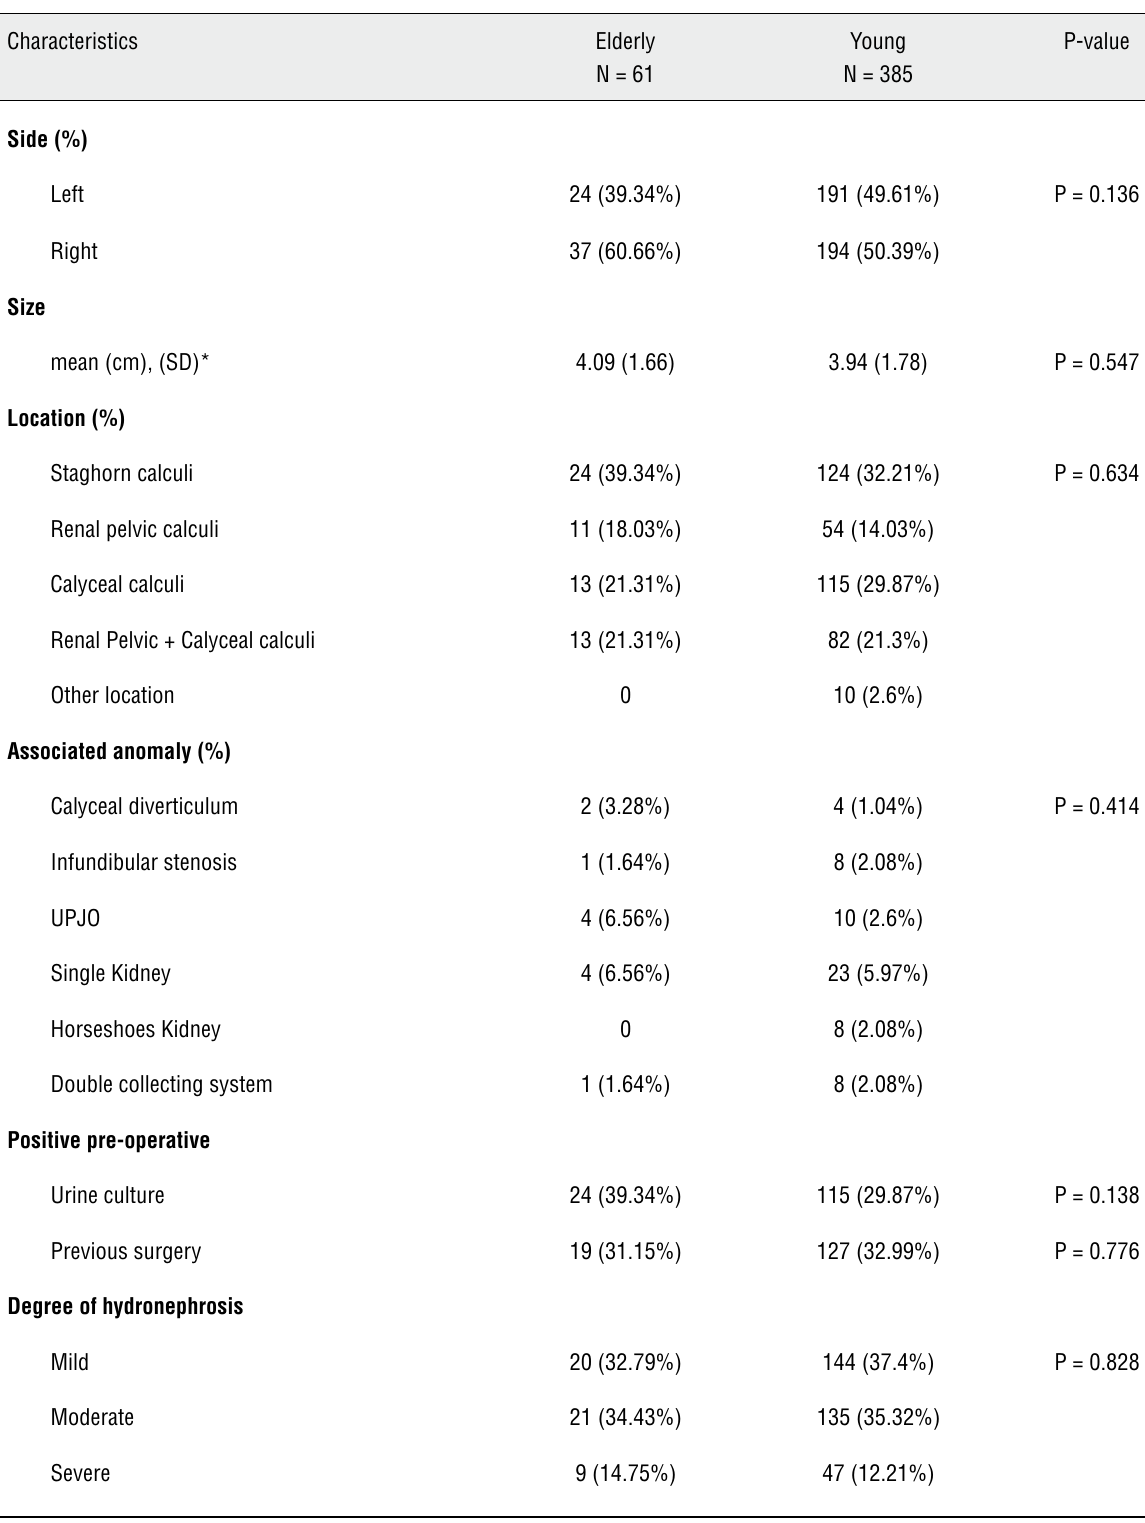
Table 3 - stone and Clinical